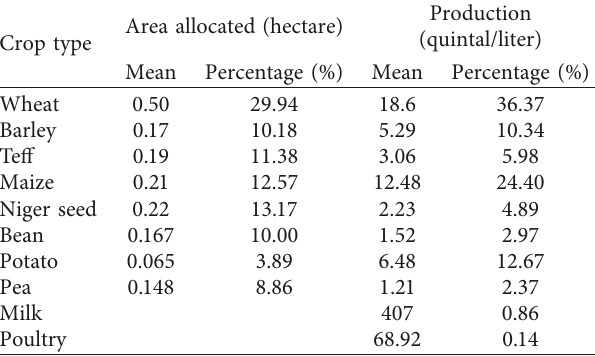
Table 3: Main crops produced by sample households. Crop